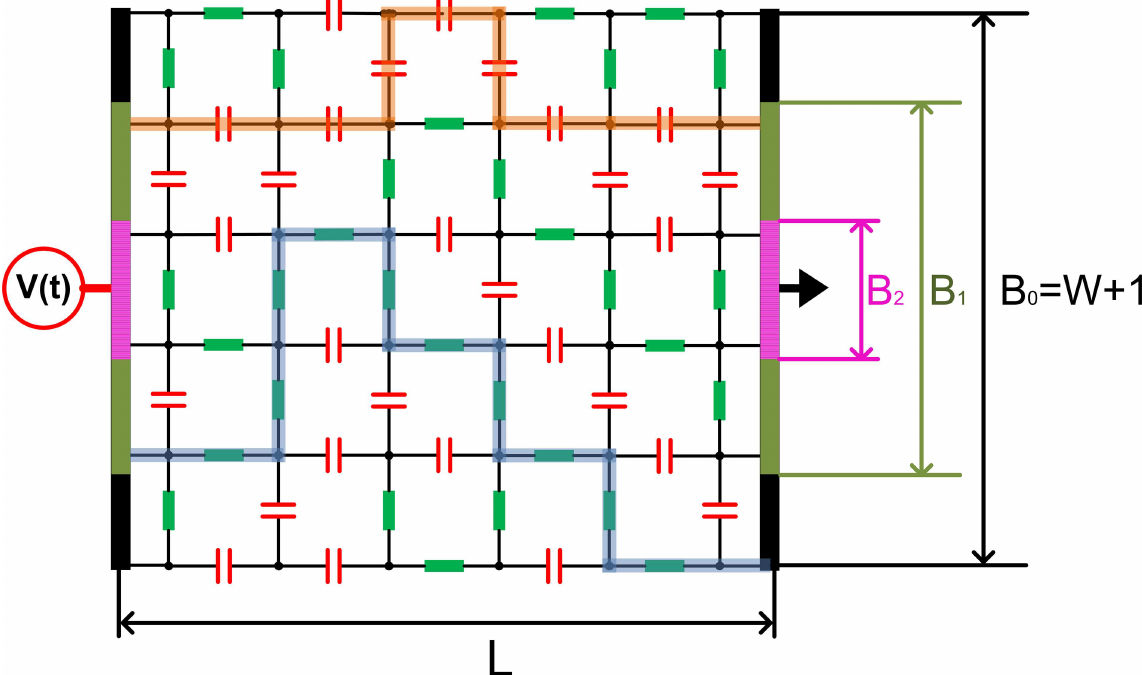
Fig 1. A lattice network containing W × L = 5 × 5 randomly distributed resistors and capacitors. The network width W and length L indicate the numbers of horizontal and vertical elementsin a singlechain, respectively. The values of B 0 = 2, B 1 = 4, and B 2 = 6 present the number of nodesconnecteddirectly to the electrodes. Percolationpaths formed by resistors and capacitorsare shown in thick blue and orangelines, correspondingrespectively to the dominating modes at low and high frequencies, for the B 0